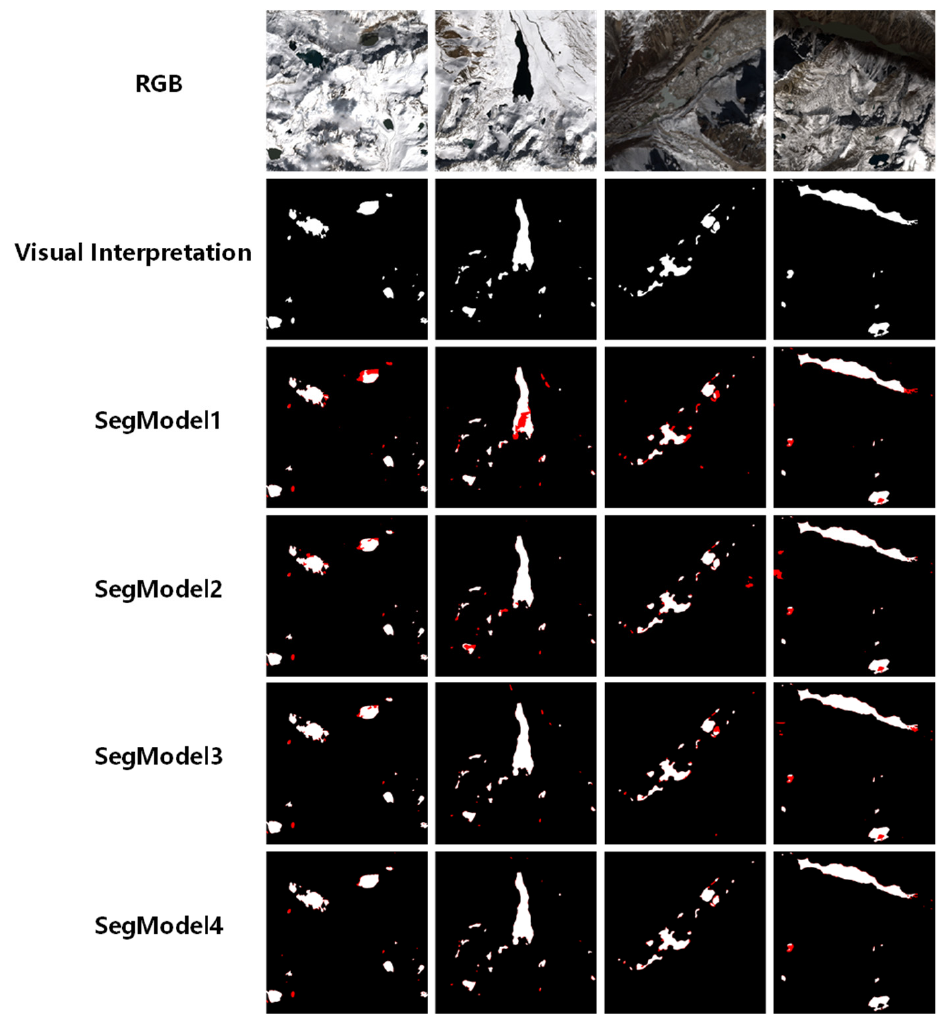
Figure 8. Example results predicted by the four segmentation models (red indicates where predicted results do not match visual interpretation).